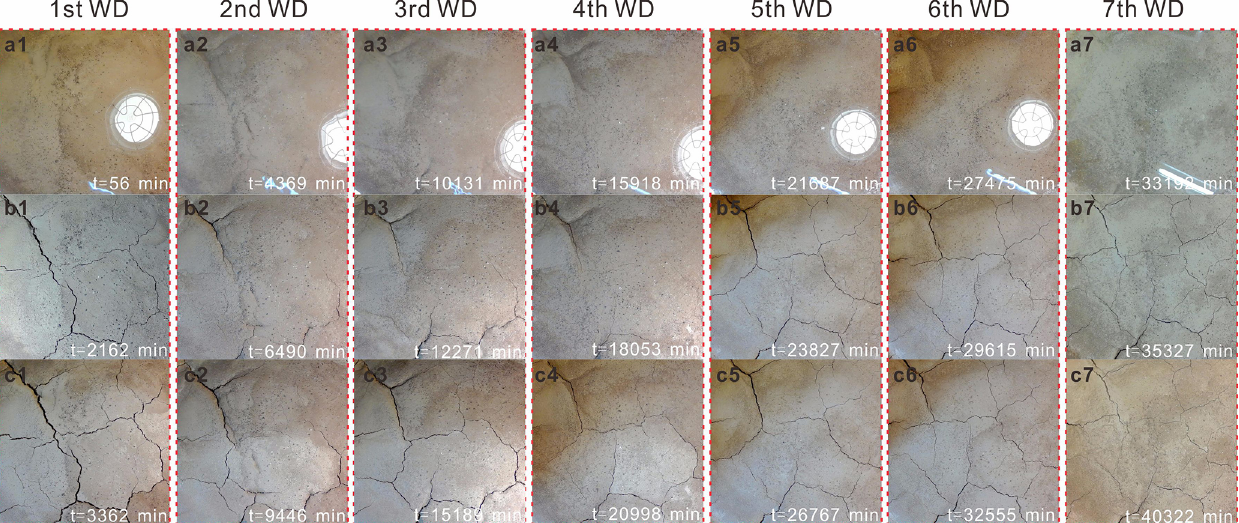
Figure 5. Typical images of crack evolution in seven wetting–drying cycles. (a1–7) Water ponds on the soil surface after rainfall, (b1– 7) crack images at the 2135th min after each rainfall event and (c1–7) crack images at the end of the final high-evaporation period during each wetting–drying cycle.